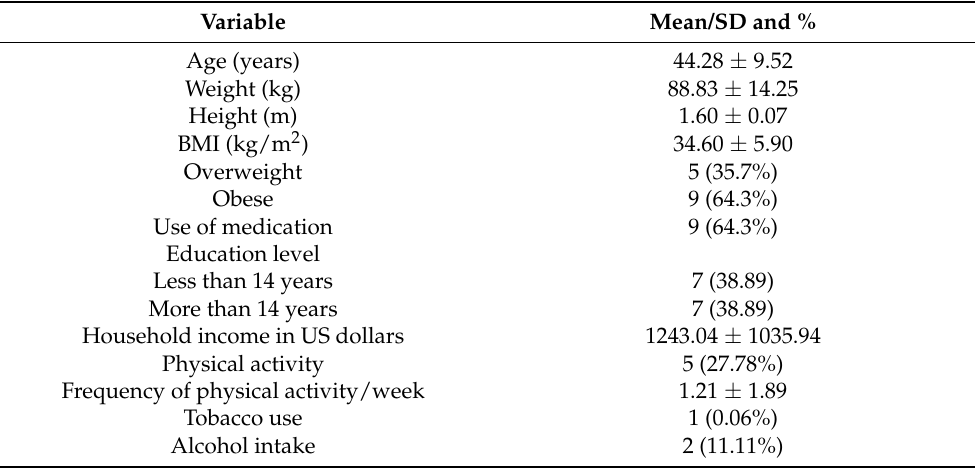
Table 1. Clinical and demographic characteristics of the sample of hypertensive women recruited from the Blood Donor Center of Jo ã o Pessoa, PB,